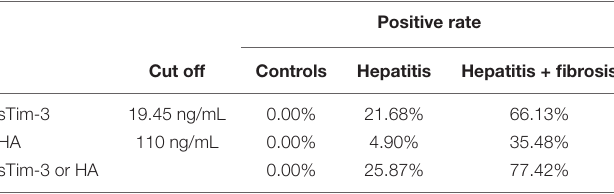
TABLE 3 | Comparison of the positive rate of sTim-3 and HA to distinguish hepatitis from hepatitis with liver